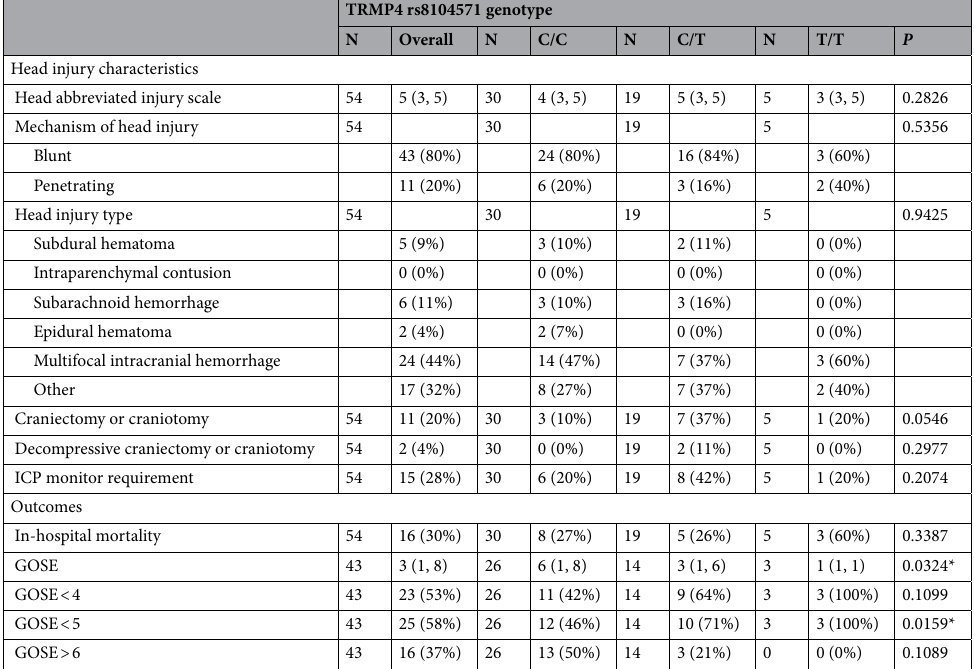
Table 8. Head injury characteristics, outcomes, and TRMP4 rs8104571 genotype distribution for African Americans within the study population denoted as median (IQR) or number of observations (%). C cytosine, T thymine, ICP Intracranial pressure, GOSE Glasgow outcome scale-extended, recorded on first follow-up visit, IQR interquartile range: *Significant P values <